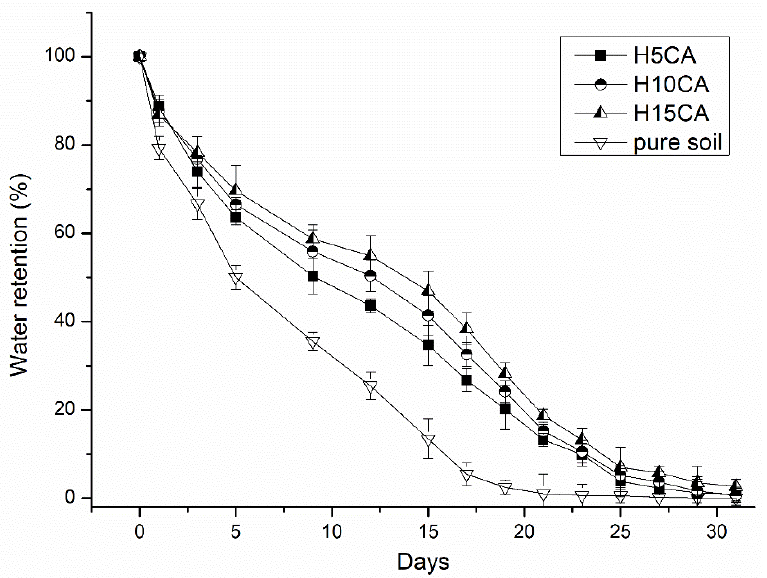
Figure 7. Water retention capacity (%) of pure soil and soil containing the hydrogels H5CA, H10CA and H15CA; data refer to mean values ± SD (n= 3).